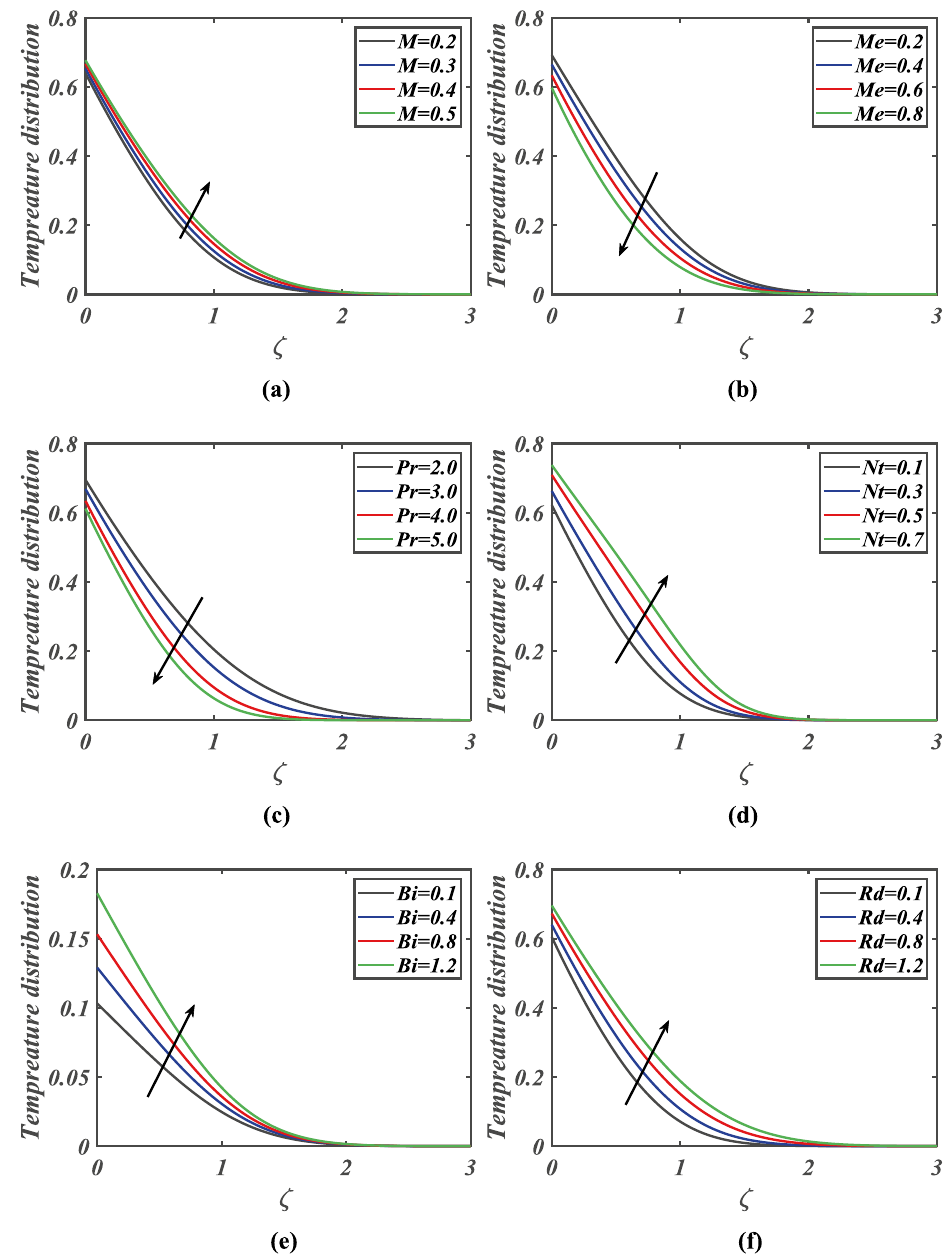
Figure 3. (a)–(f) Response of temperature θ against varied values of M , Me , Pr , Nt , Bi and Rd